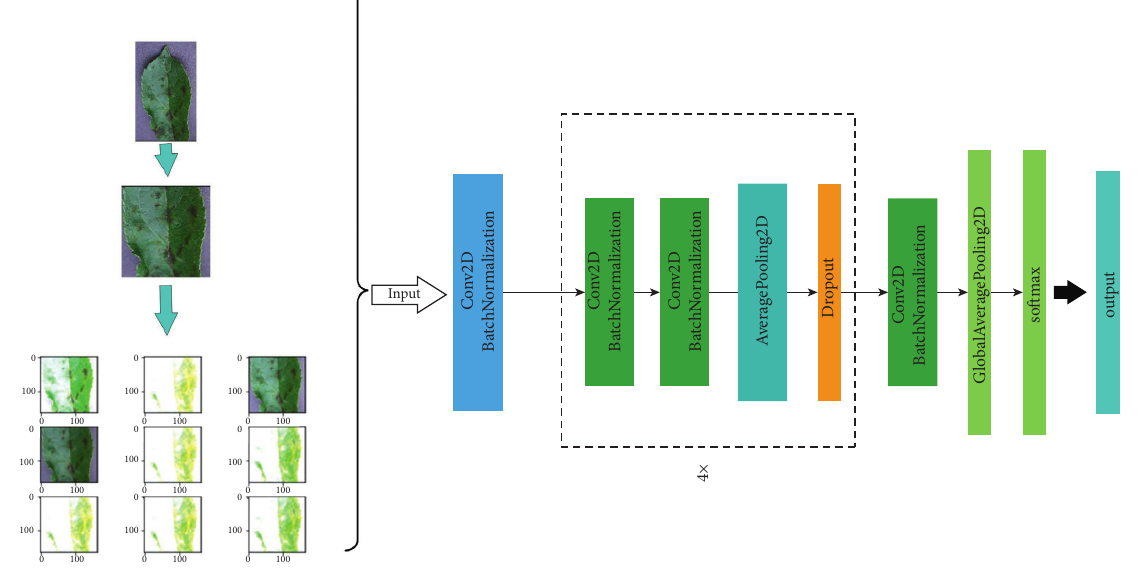
Figure 7: Overview of the improved CNN. Table 1: Parameters setting in the proposed CNN.